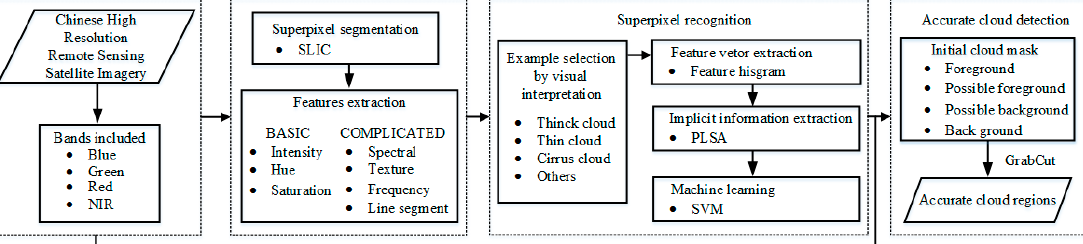
Figure 2. Proposed cloud detection framework.